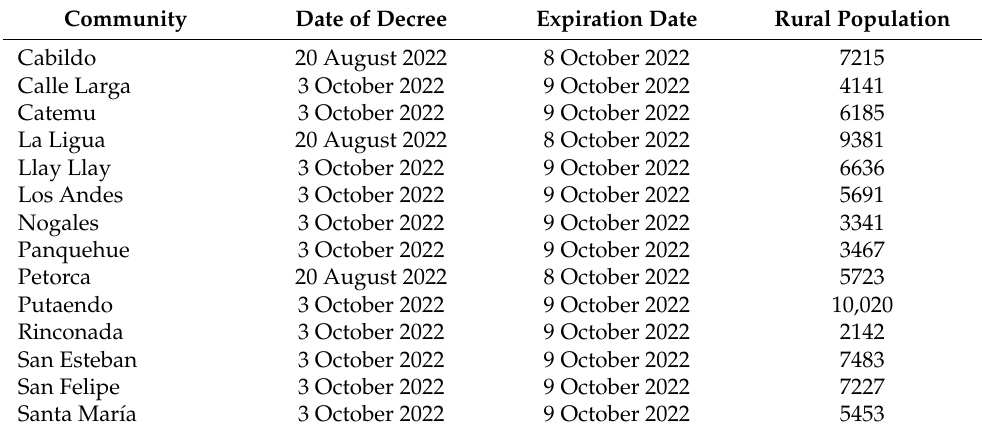
Table 3. Water scarcity